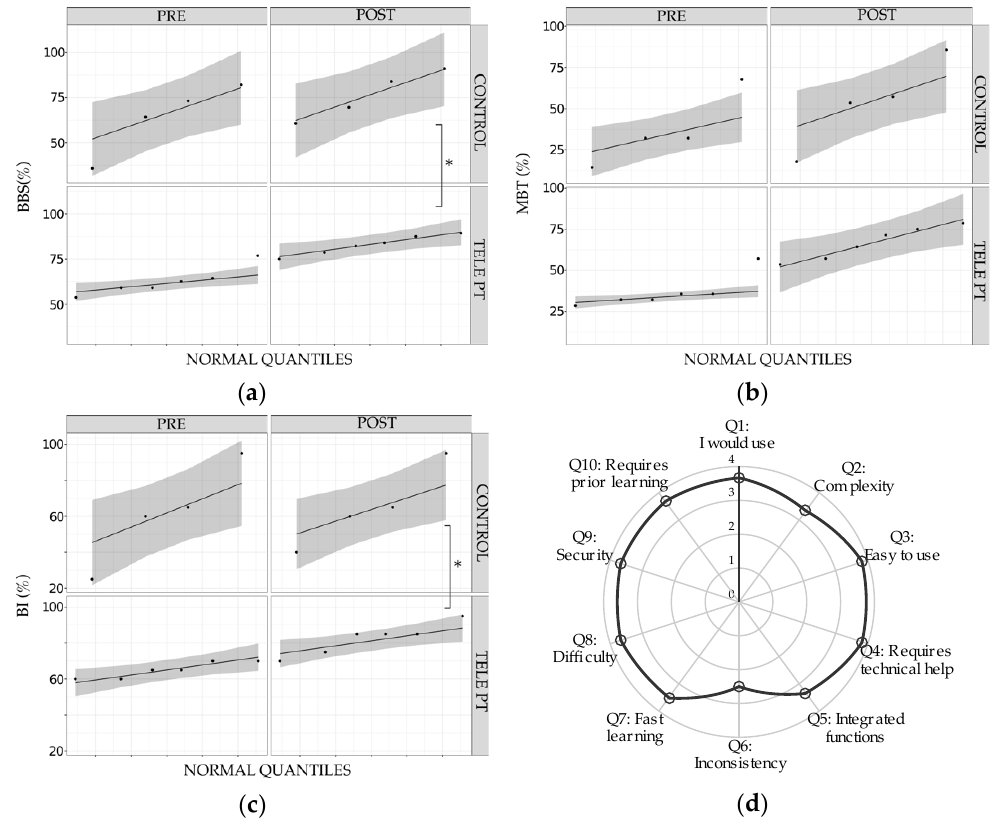
Figure 3. Balance and functional progress in telerehabilitation group, and system usability: ( a – c ) improvement within PRE and POST sessions by group (TELEPT vs. CONTROL): BBS: Berg Balance Scale, MBT: MiniBesTest, and BI: Barthel Index. The points represent the individual scores in a qq plot, the gray area represents the dispersion (theoretical confidence interval at 95%), and the asterisk shows significant differences of PRE–POST variation between groups (ANOVA 2-WAY RM); ( d ) usability evaluation with SUS scale (10 questions), from 0 to 4.